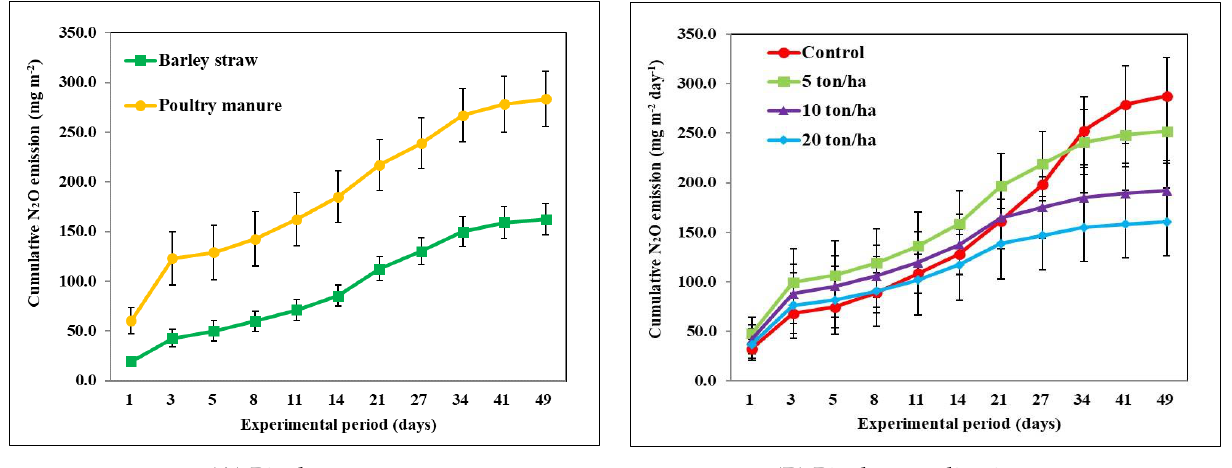
Figure 2. Cumulative N 2 O emission according to biochar types and application rates under incuba- tion conditions during the 49 days. The error bars represent standard errors (n = 3). ( A ): Cumulative N 2 O emission by biochar types on all soil characteristics. ( B ): Cumulative N 2 O emission by biochar types on all soil characteristics.